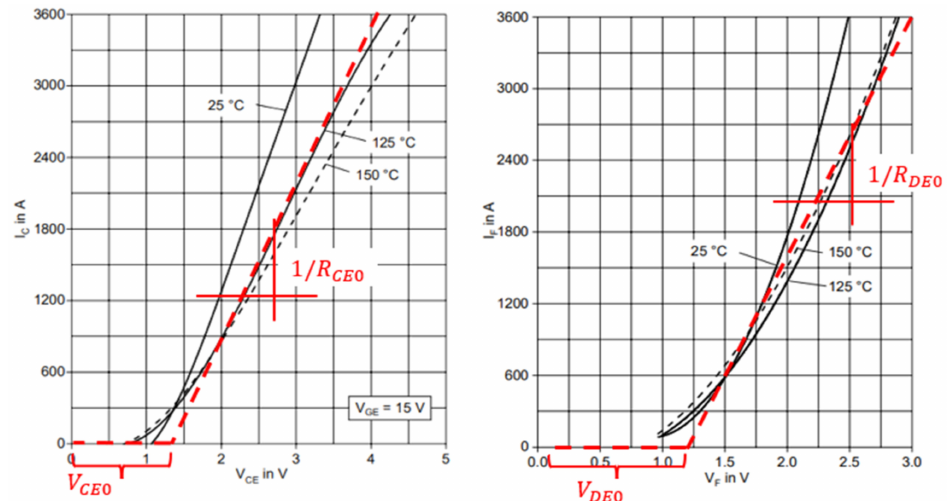
Figure 4. Collector current–collector emitter voltage curves for the IGBT ( left ); forward current– forward voltage curves for the associated freewheeling diode ( right